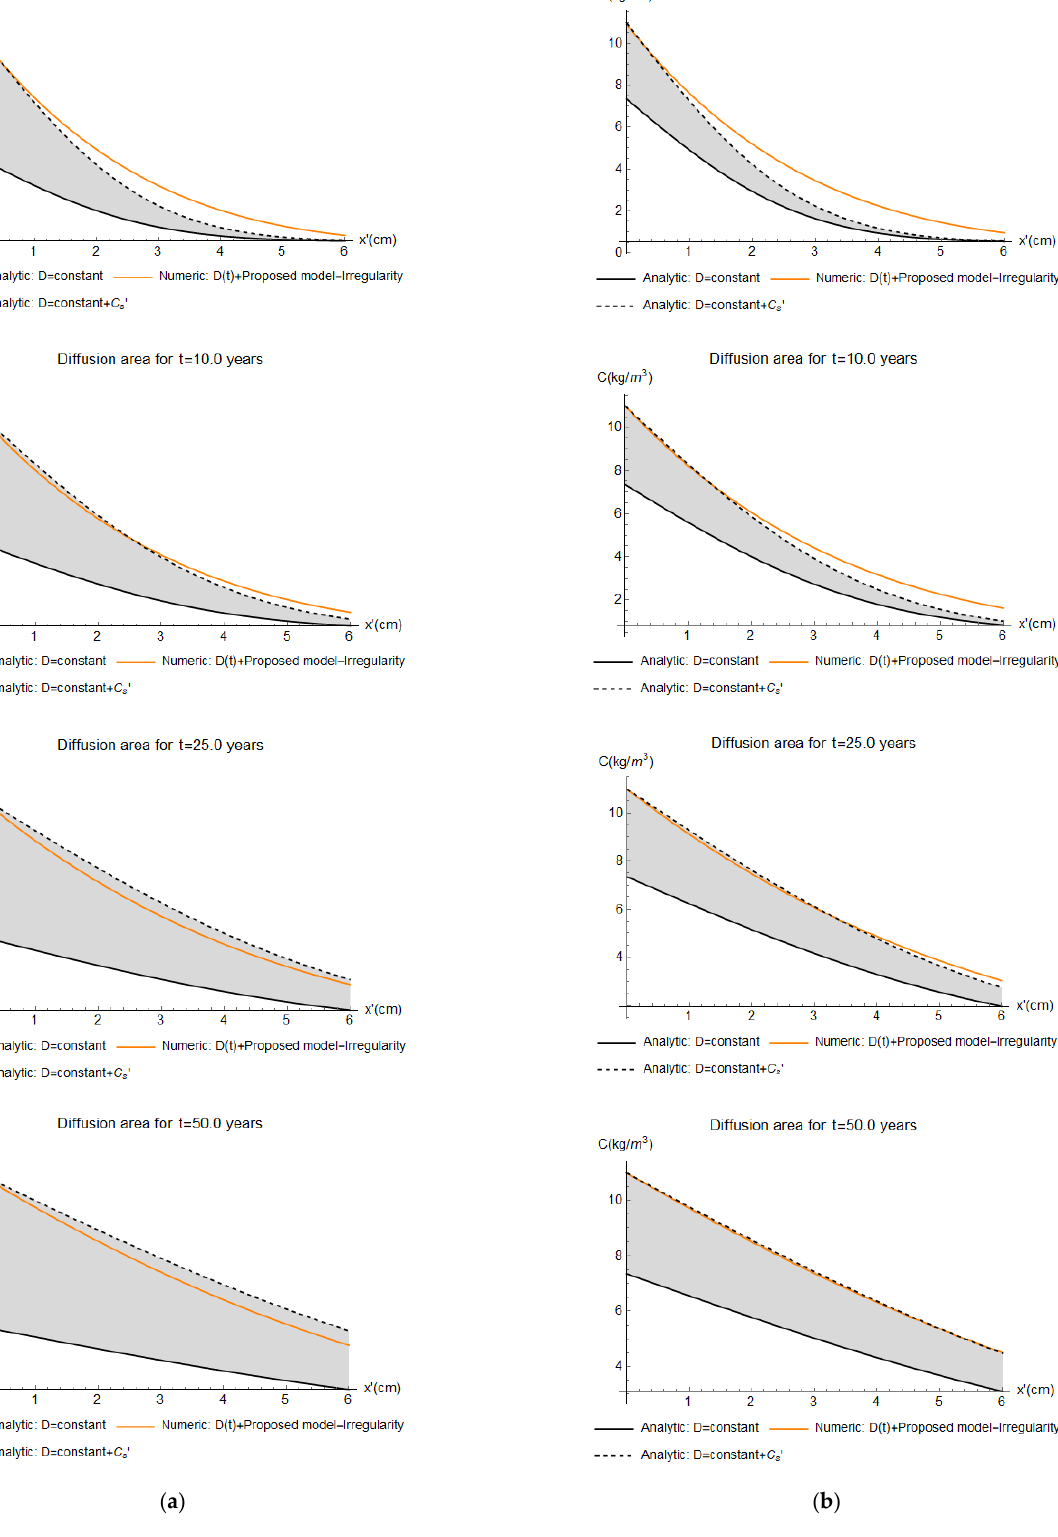
Figure 9. C-x’ curves by analytical and numerical solutions for ( a ) high and ( b ) extreme levels of aggressiveness.